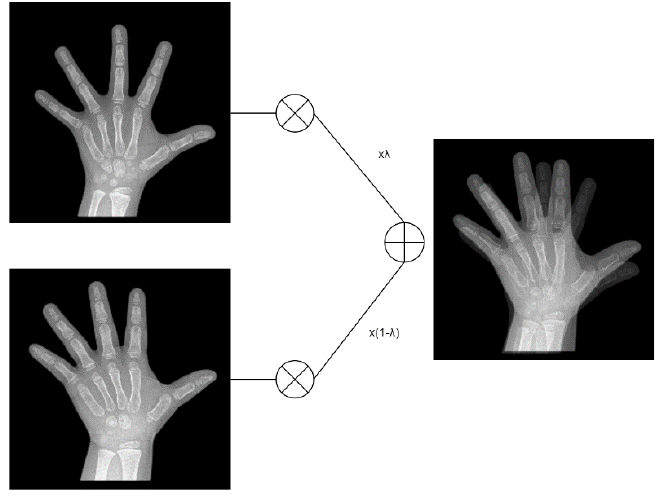
Figure 7. The operation of mixup.